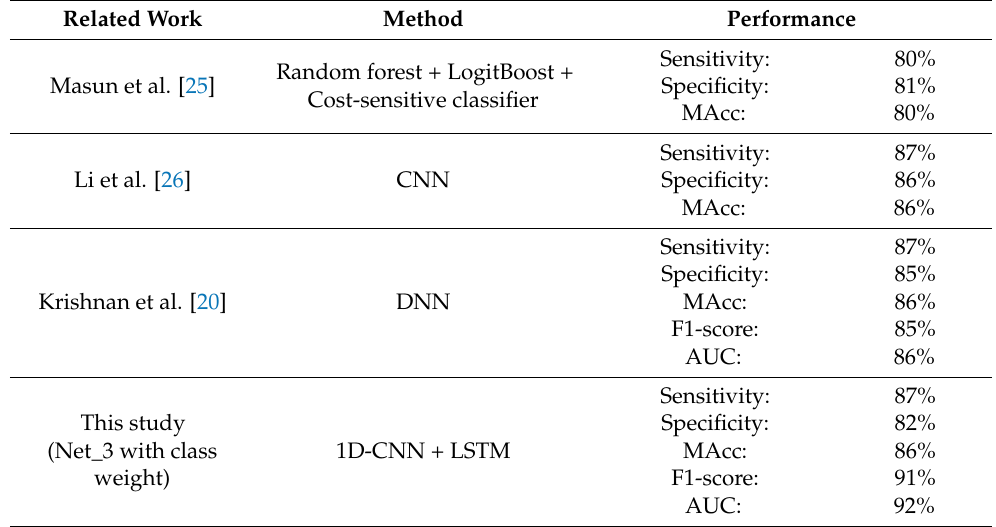
Table 5. Comparison of related work in heart-sound classification based on Physionet Challenge 2016